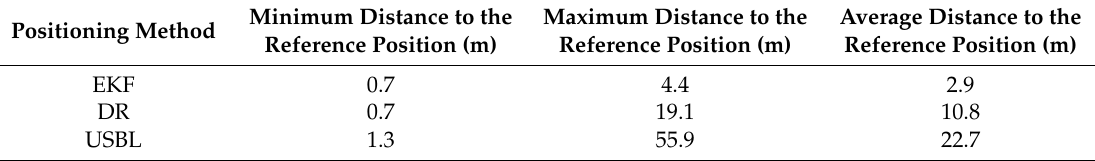
Figure 26. Histogram of the reference position distance from the position estimated by EKF and DR methods and determined by the USBL system (one hundred passages). Table 8. Statistical parameters of positioning errors using EKF, DR methods and the USBL system (single passage).